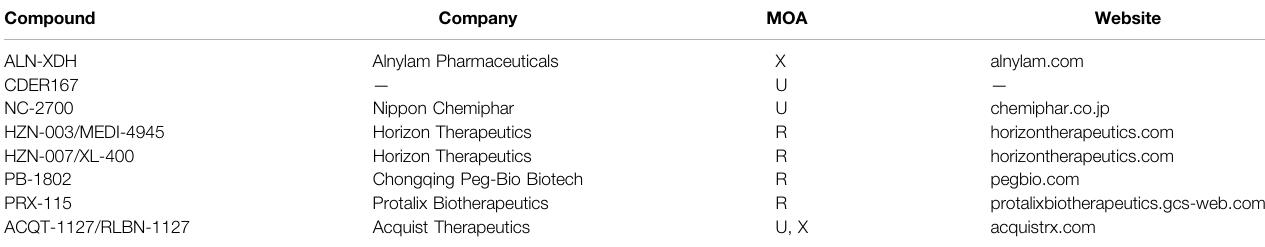
TABLE 3 | Developmental pipeline for urate-lowering therapeutic agents in the clinical phase of development.